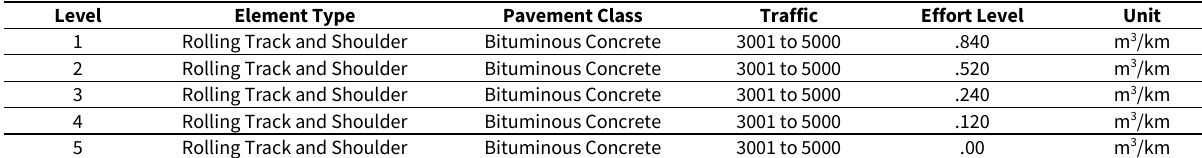
Table 3. Details of Effort Levels for the Hole Covering Service